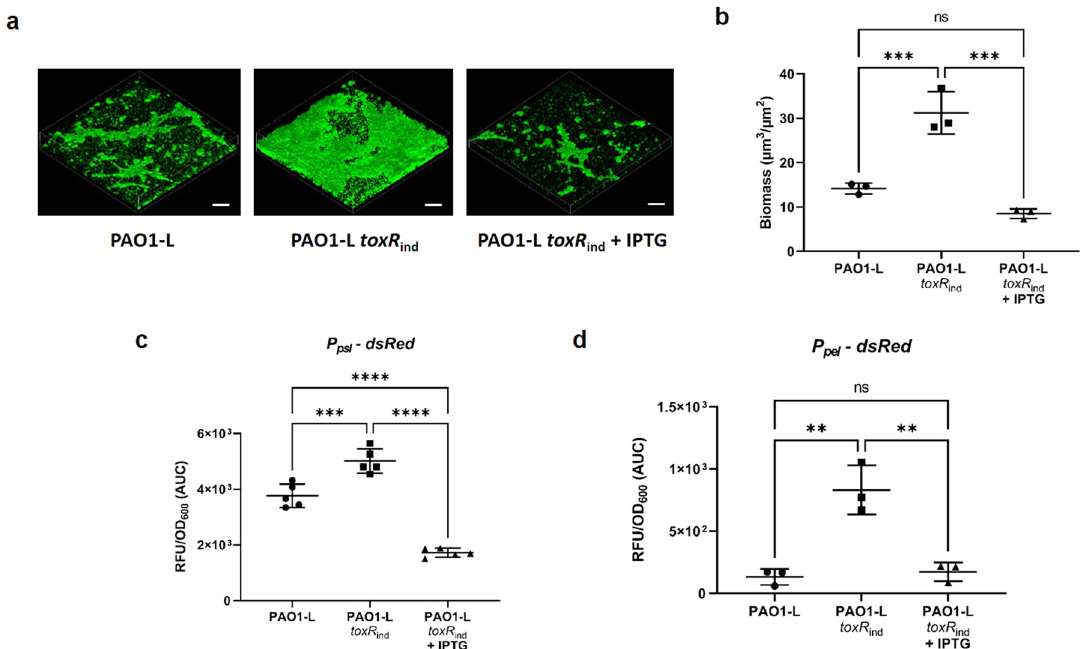
Fig. 5 ToxR has a negative impact on bio fi lm formation and psl and pel expression. a Confocal images of mClover3 -labelled P. aeruginosa PAO1-L WT and toxR ind mutant ±1 mM IPTG bio fi lms obtained after 48 h incubation in micro fl uidic channels (Bio fl ux, Fluxion) in RPMI-1640 medium. Scale bar: 100 µM. b Quanti fi cation of biomass from confocal images of PAO1-L WT and toxR ind mutant (±1 mM IPTG) bio fi lm cultures using Comstat2 89 . c and d Effect of toxR mutation on EPS biosynthetic gene transcription. Expression was determined by measuring the fl uorescence from wild type PAO1-L and the toxR inducible mutant toxR ind cells (±1 mM IPTG) carrying the transcriptional fusions ( c ) P psl -dsRed and ( d ) P pel - dsRed in their chromosomes and grown at 37 C for 24 h in LB. Reported values are averages from three different cultures ± SD and correspond to the area under the curve (AUC) derived from plotting relative fl uorescent units normalized to culture density (RLU/OD 600 ) over time. Statistical differences between group means were determined by one-way ANOVA analysis using Tukey ’ s multiple comparisons test. (* p < 0.05, ** p < 0.01, *** p < 0.005, **** p < a Surface Plasmon Resonance (SPR) binding assay using puri fi ed